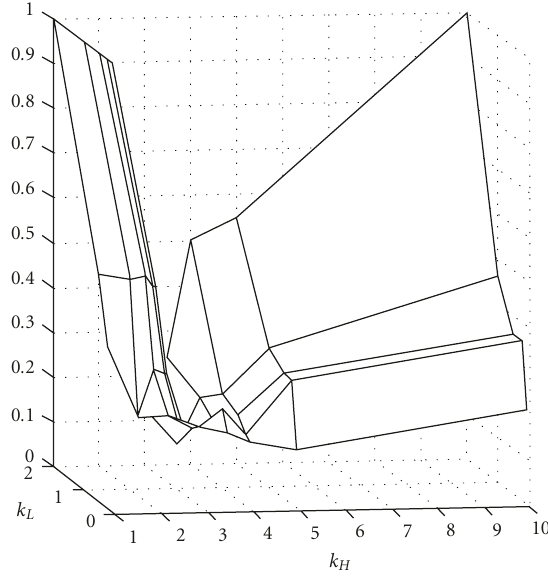
Figure 5: Variation of the segmentation error with the low and high threshold values. Thresholds are indicated as the factors k L ( y -axis) and k H ( x -axis) to apply to the mean square value of the Kullback- Leibler distance MS KL